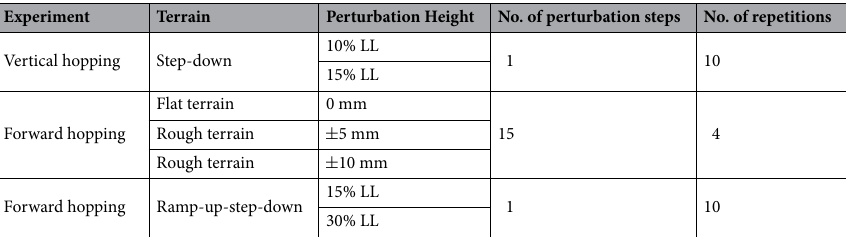
Table 1. Experiment design, all experiments are repeated with damper slack values of 10, 6, 3, and 0 mm, from maximum slack to no slack.